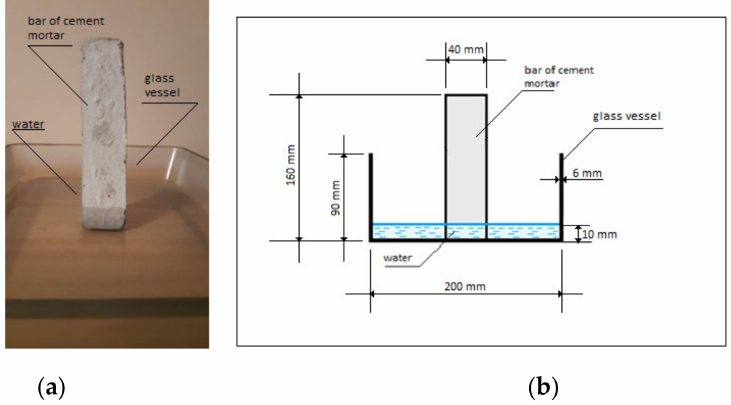
Figure 5. A cement masonry mortar bar: ( a ) side view; ( b ) scheme of the stand for the capillary suction test of the cement masonry mortar.